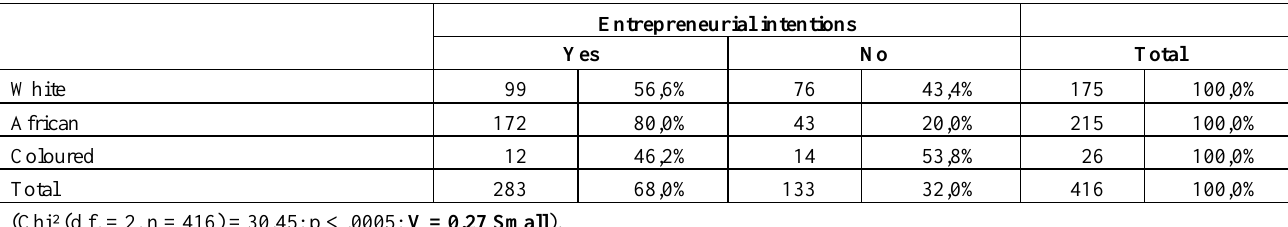
Entrepreneurial intentions